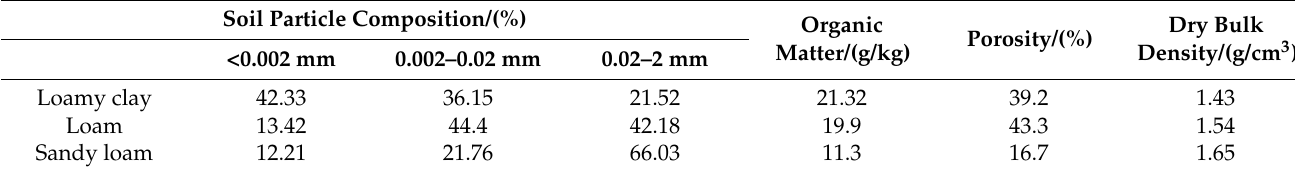
Figure 1. Location map of the study area. Table 1. Physical indicators of different soil qualities in the study area.